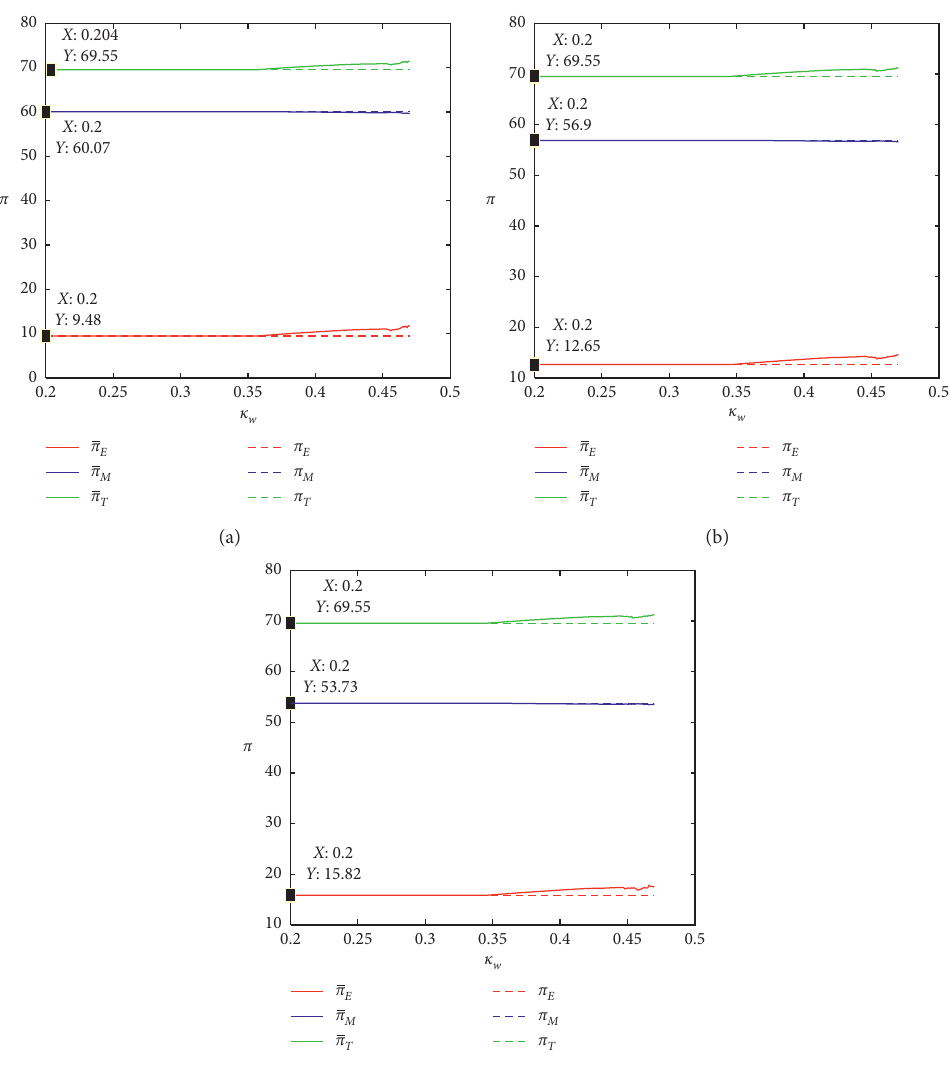
Figure 10: Supply chain members’ average profits via κ